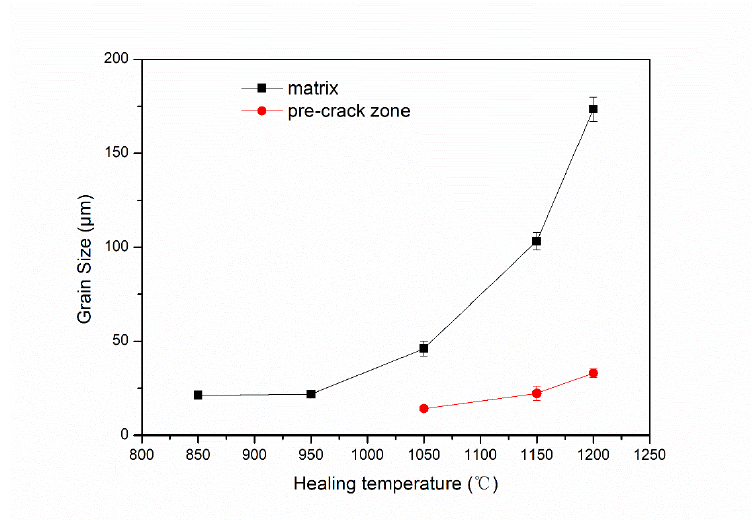
Figure 5. The grain sizes of the matrix and pre-crack healing zones in SA 508–3 steel samples under different healing